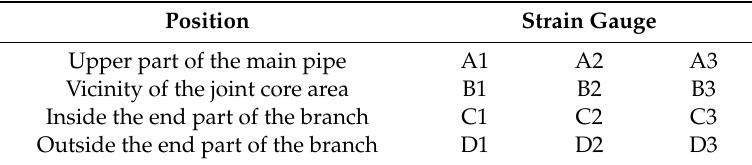
Figure 14. Distribution diagram of measurement points for the joints model. Table 6. Locations and notation of measurement points